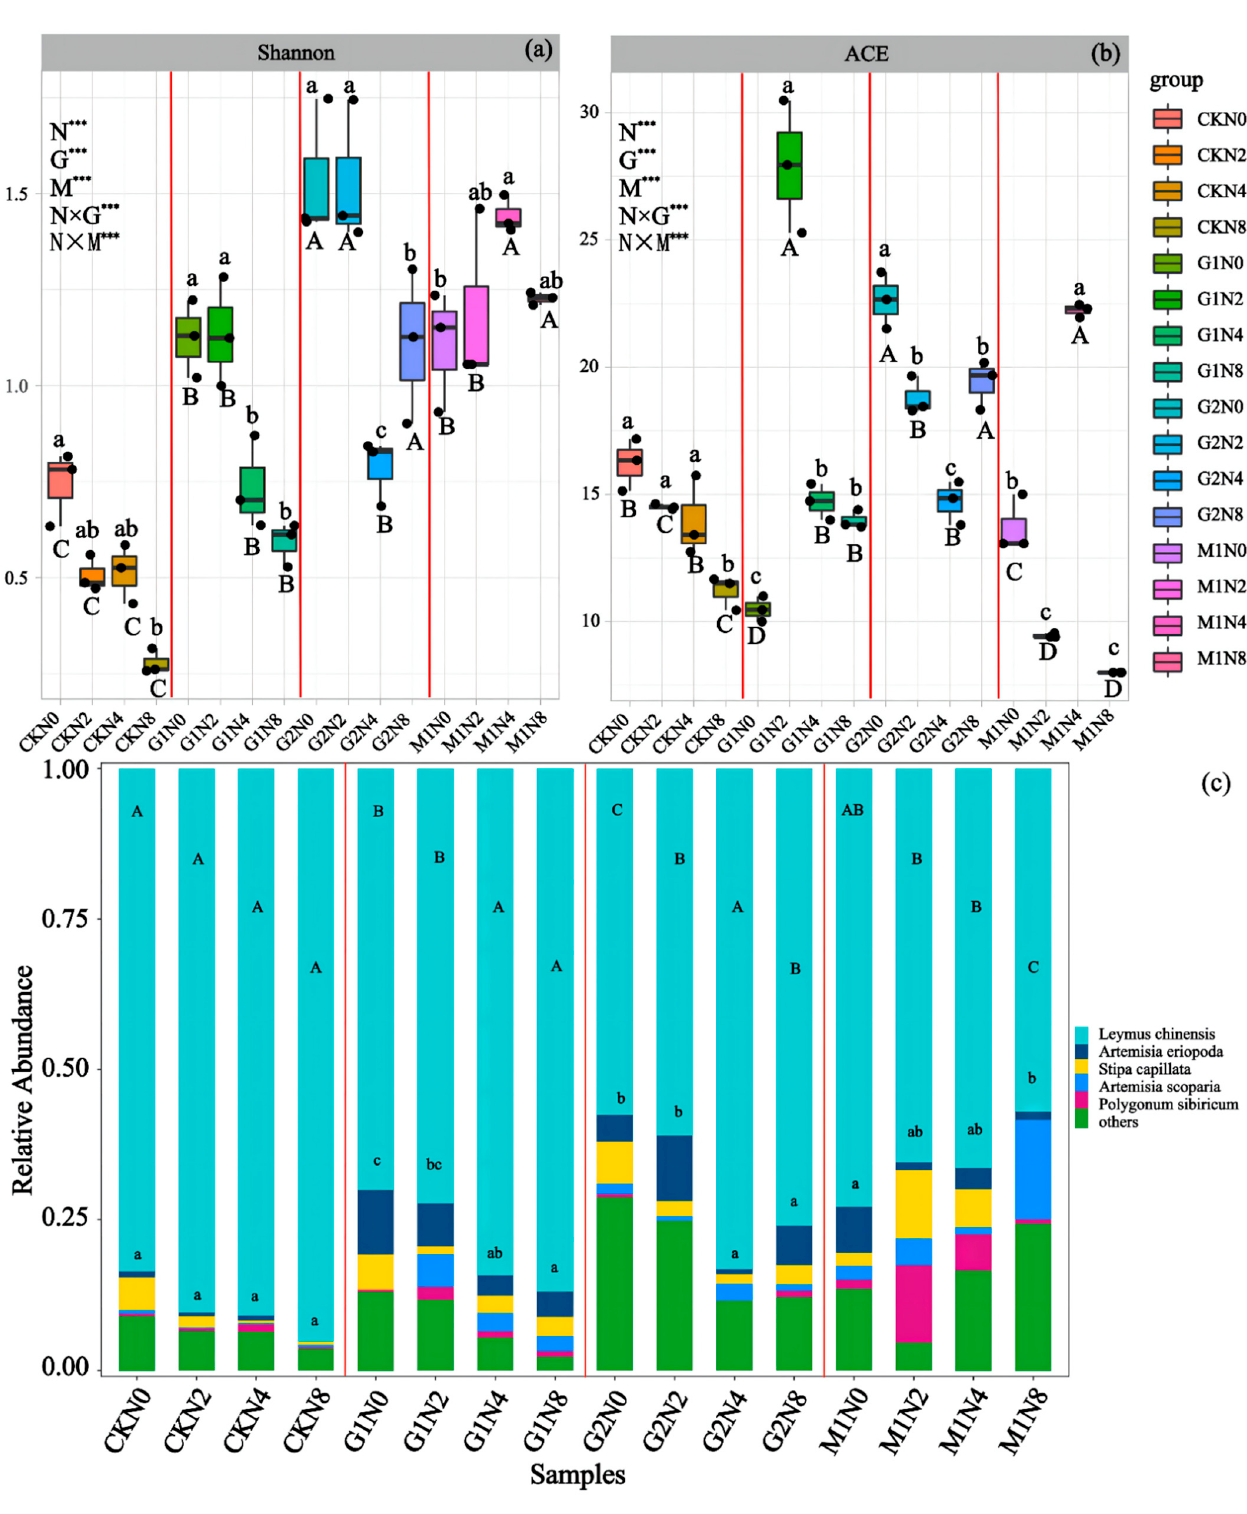
Figure 4. Effects of grazing sheep (G1, G2) and mowing (M1) on grassland plant community at different nitrogen deposition levels (N0, N2, N4, N8); ( a ) Shannon index; ( b ) Abundance coverage-based estimator (ACE); ( c ) Relative abundance of species. Different lowercase letters indicate significant differences among different treatments under the same nitrogen deposition level ( p < 0.05); different capital letters indicate significant differences among different nitrogen deposition levels under the same treatment ( p < 0.05). Significant effects of treatments are marked with an asterisk. Triple asterisks indicate the significance level at p < 0.001.